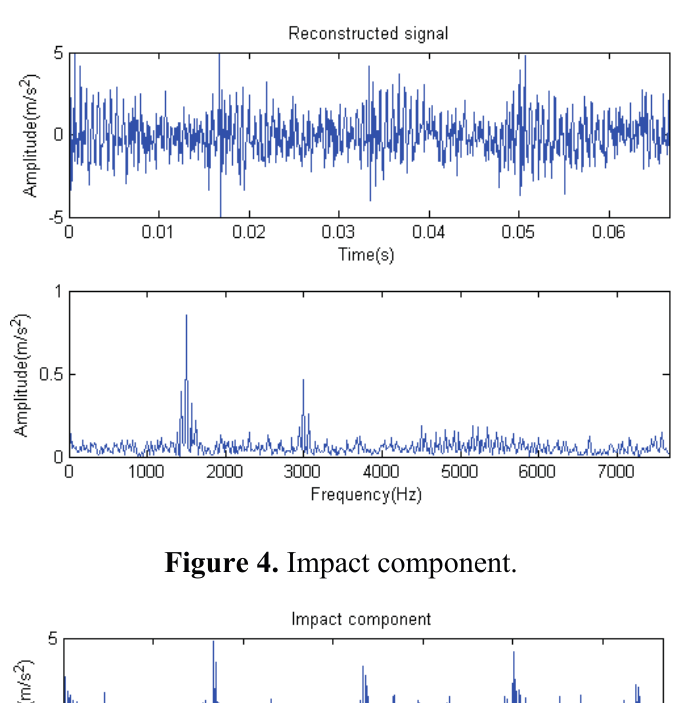
Figure 3. Reconstructed signal.